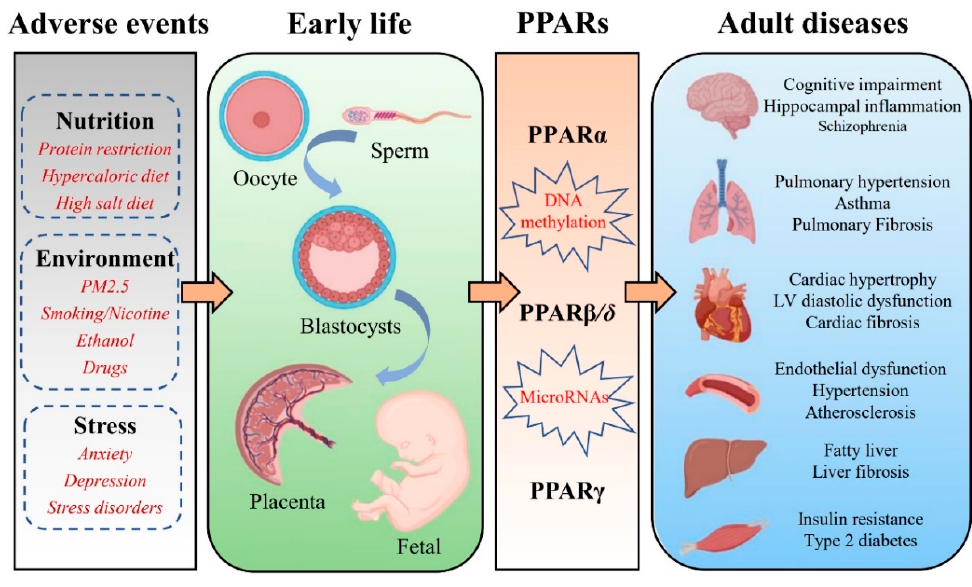
Figure 1. Schematic illustration of potential mechanisms to support the association between early- life adverse events exposure and epigenetic regulation of PPARs that promote chronic diseases in adulthood.